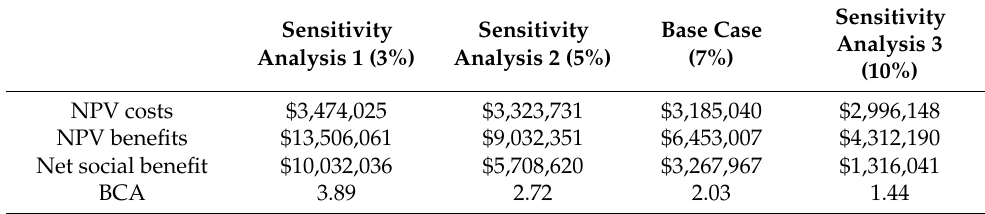
Table 4. Sensitivity analysis using variations in discount